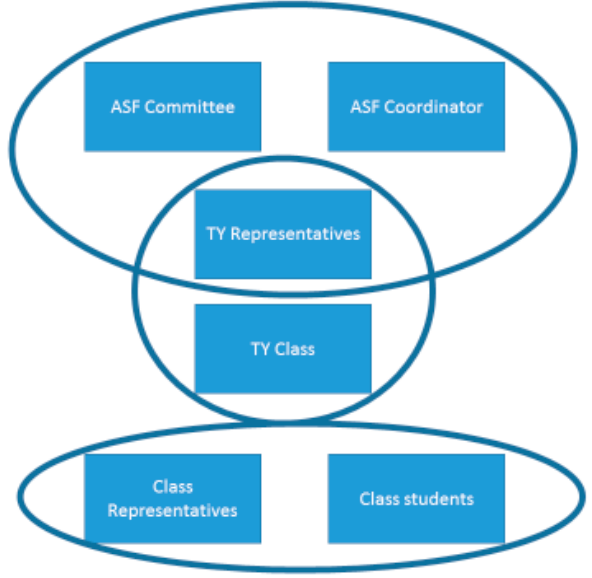
Figure 2. Actors of the Second Level Active school Flag.